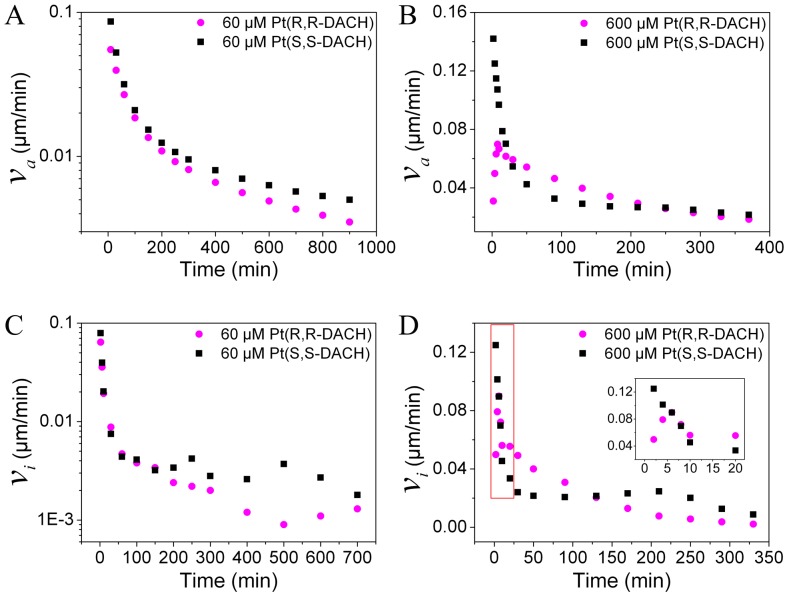
The average DNA condensation rates (νa) and the instantaneous DNA condensation rates (νi).